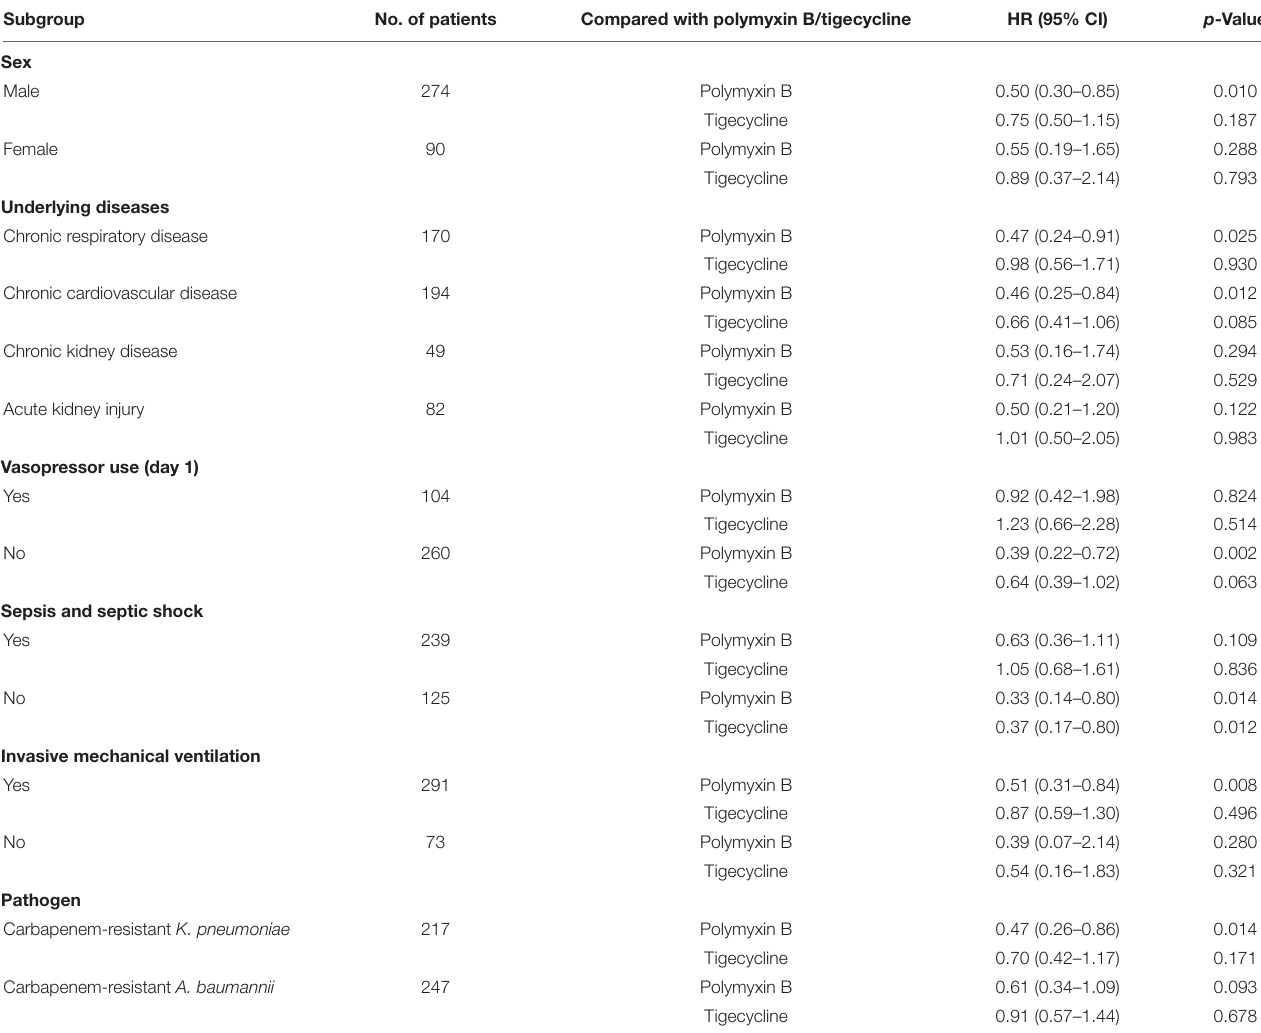
TABLE 3 | Subgroup